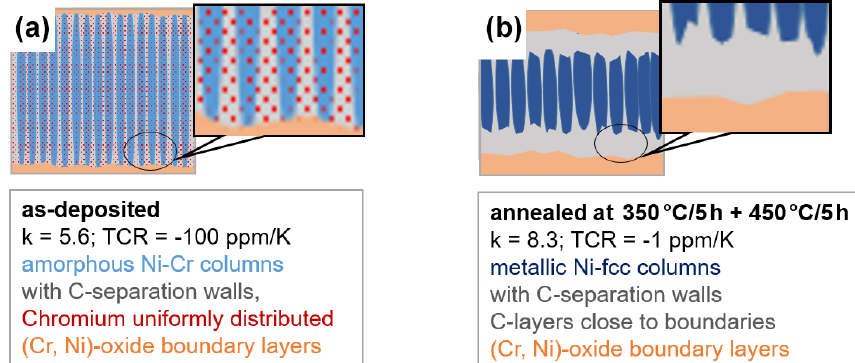
Figure 7. Model sketches of films of Ni 50 Cr 50 -C. (a) as-deposited (b) after annealing at 350 ◦ C per 5h + 450 ◦ C per 5h. The electrical properties and structural microscopic features, derived from the TEM element distribution scans are